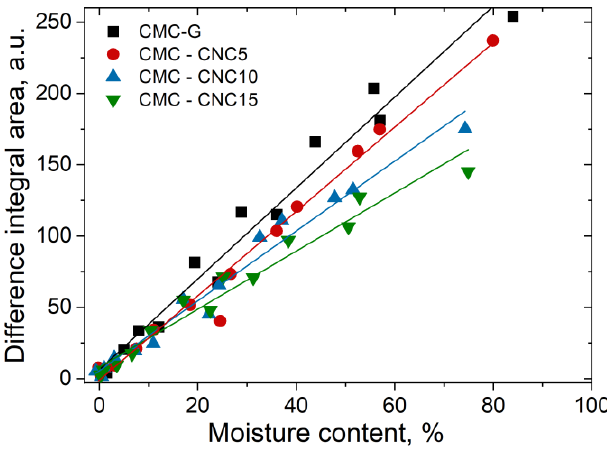
Figure 11. Integral area of the difference bands vs. moisture content.